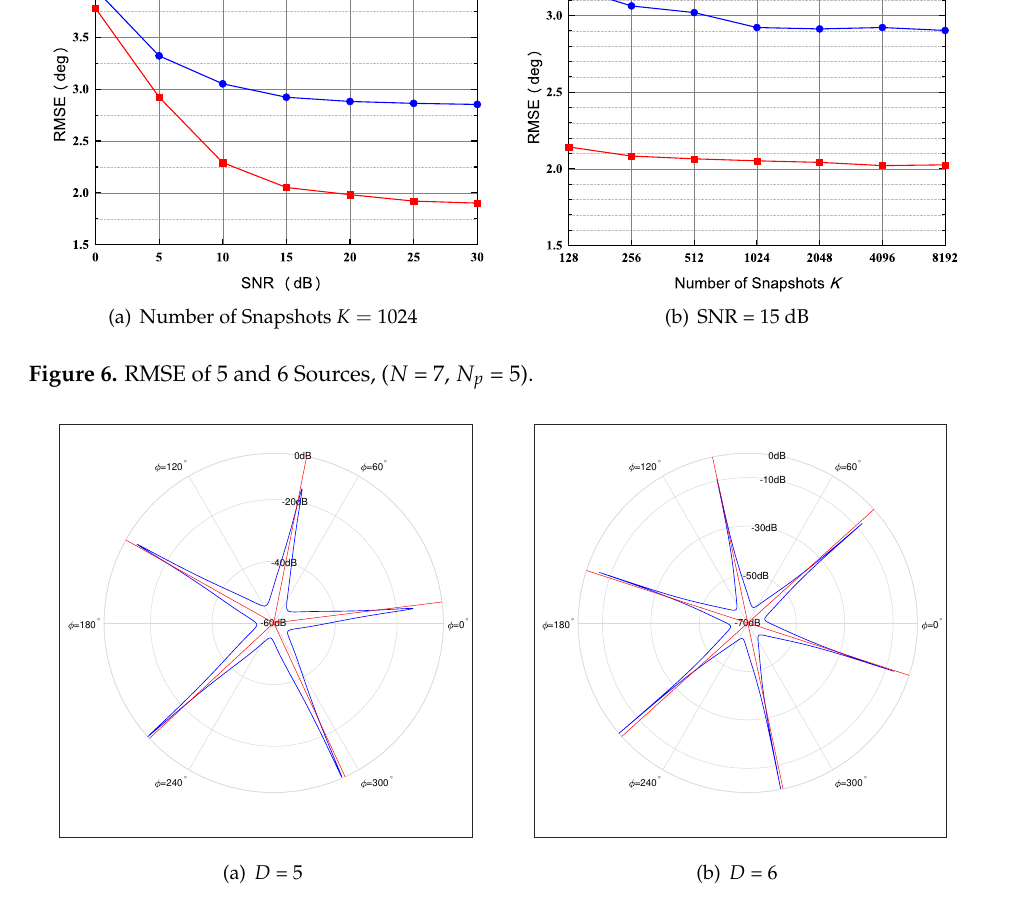
Figure 7. Normalized Spatial Spectrum of 5 and 6 Sources, N = 7, N p = 5; (SNR=10 dB, K =